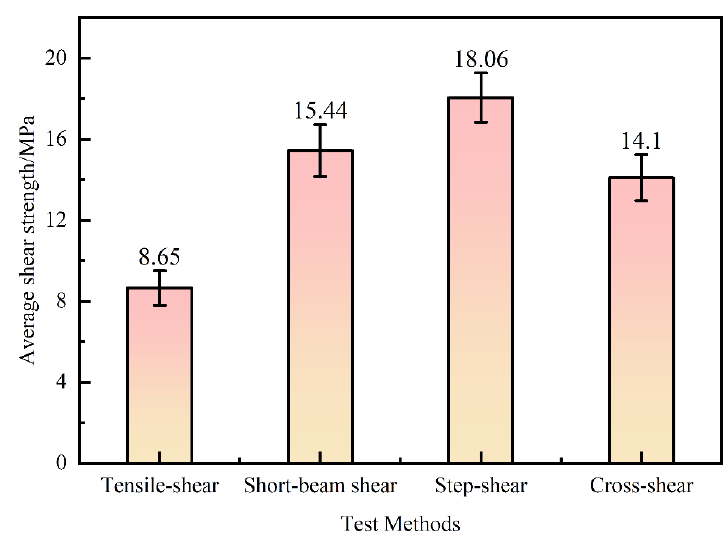
Figure 1. Shear strengths under different test methods.